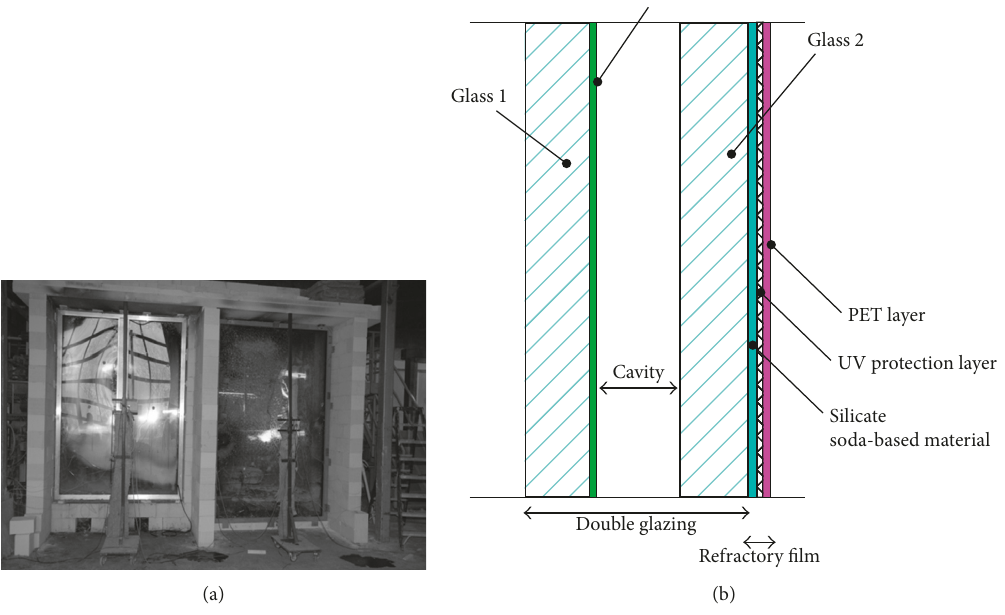
Figure 11: Experiments on coated glazing windows, as reported in (a) [72] and (b) [73], schematic cross-sectional